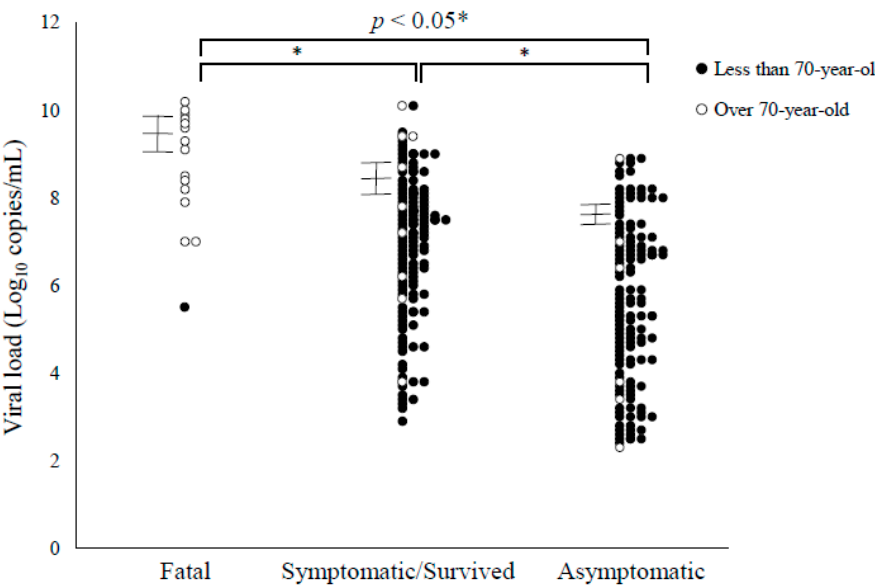
Figure 1. Viral load of SARS-CoV-2 in the present cases. Black circles, less than 70-year-old cases; White circles, over 70-year-old cases. Error bars represent 95% confidence intervals.